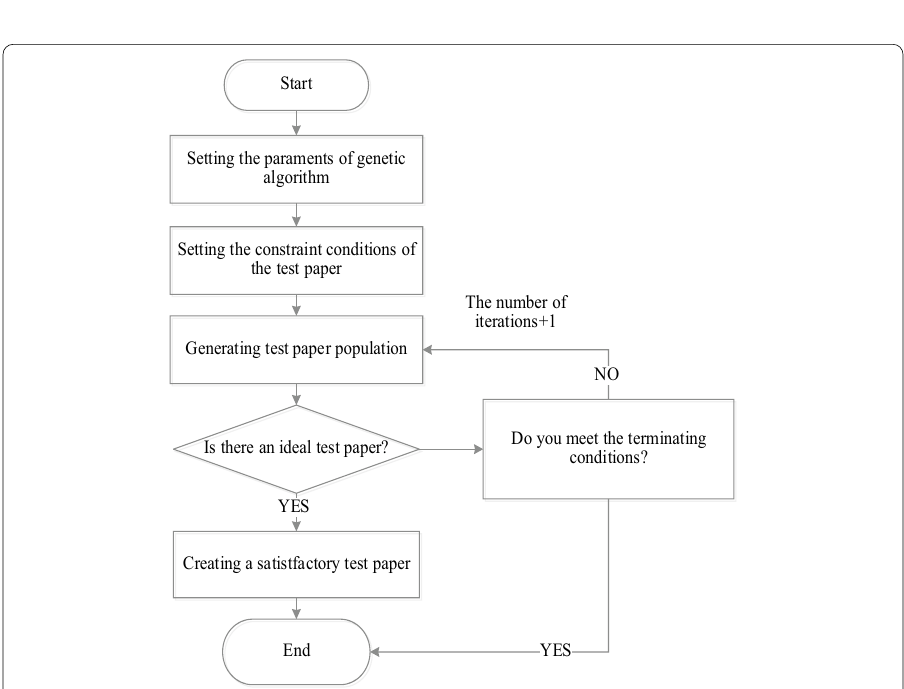
Fig. 2 The implementation process of classification